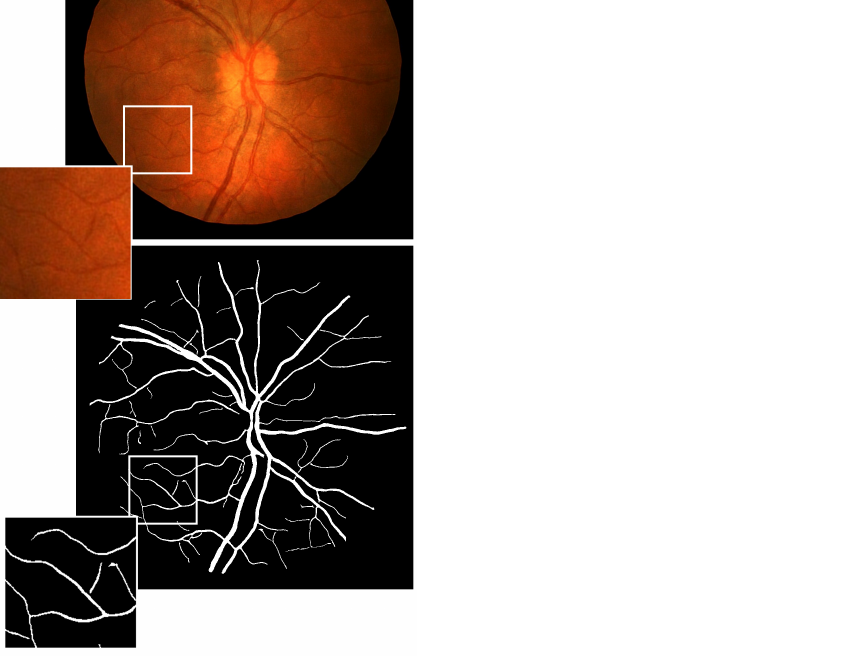
Figure 8. Example of a generated image (resolution 1024 × 1024) with the corresponding label-map from the CHASE_DB1 dataset.